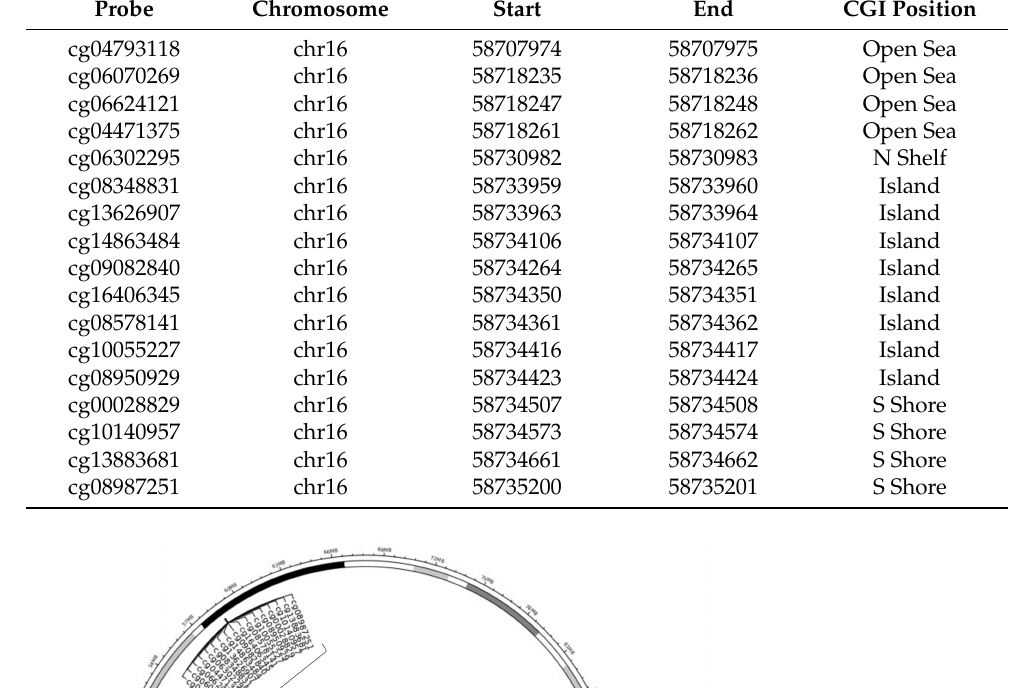
Table 2. List of the 17 probes analyzed. CGI: CpG islands.